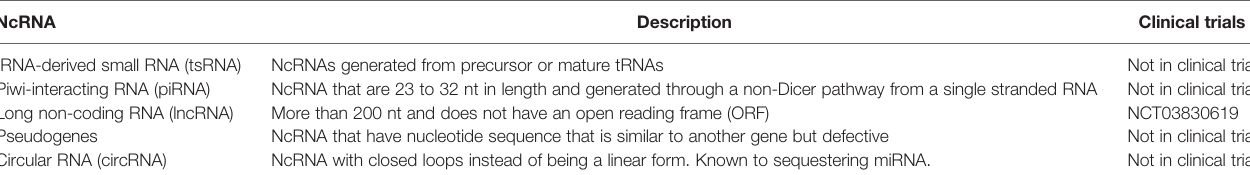
TABLE 3 | Circulating ncRNA candidates for NSCLC diagnosis.